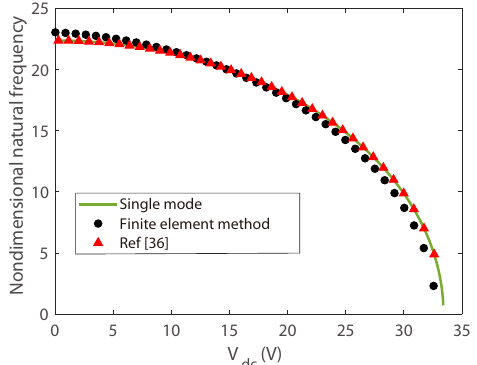
Figure 2. Comparison of eigenfrequency of the first transversal vibration.